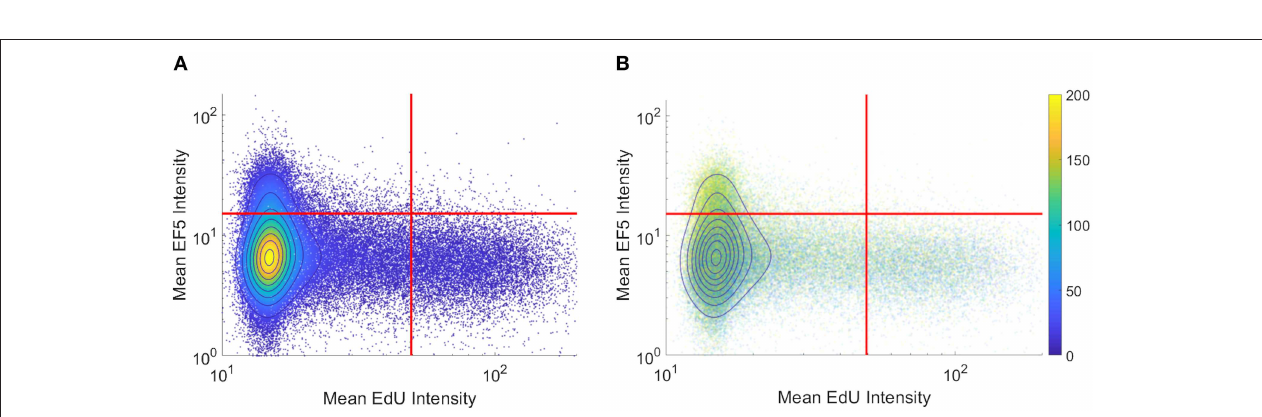
FIGURE 2 | (A) Immunofluorescence image of KP4 xenograft. Stains include DAPI (blue), Hoechst (red), and EF5 (green). (B) ROI overlay of necrosis (blue), hypoxia (red), viable tumor (orange), and perfusion (gray). (C) Distance map to Hoechst perfusion area is shown in blue, with intensity decreasing in proportion to the distance away from the Hoechst positive region. (D) Viable tumor area decreasing and necrotic area increasing as a function of distance from perfused vessels, with hypoxic area peaking near 180 µ m.